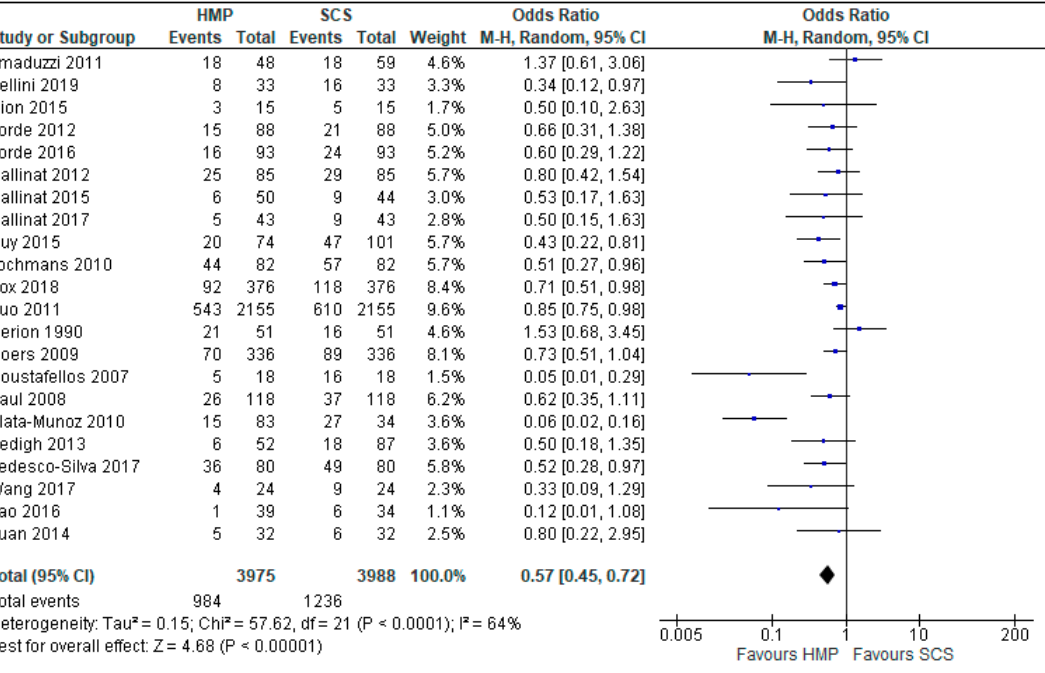
Figure 3. DGF in kidneys preserved by hypothermic machine perfusion and cold storage.